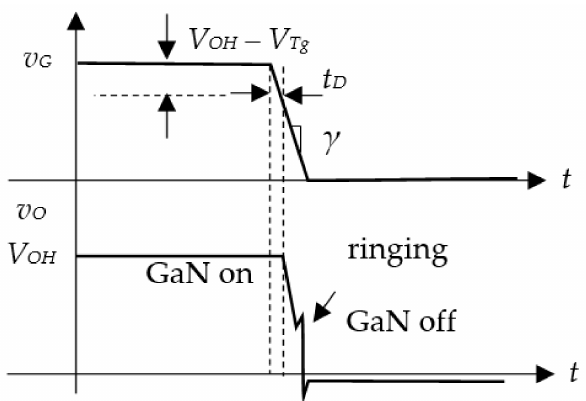
Figure 11. Operational region of gate voltage for P-Cascode GaN HEMT.